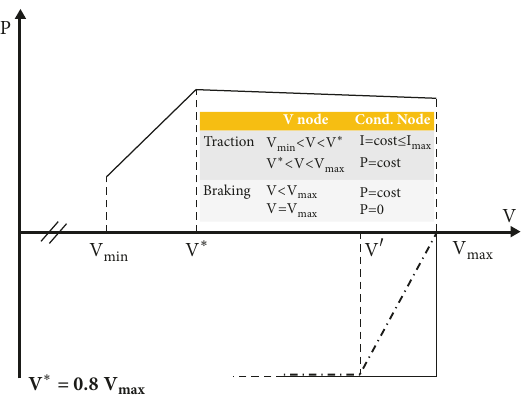
Figure 2: Voltage-power characteristicduring traction and braking